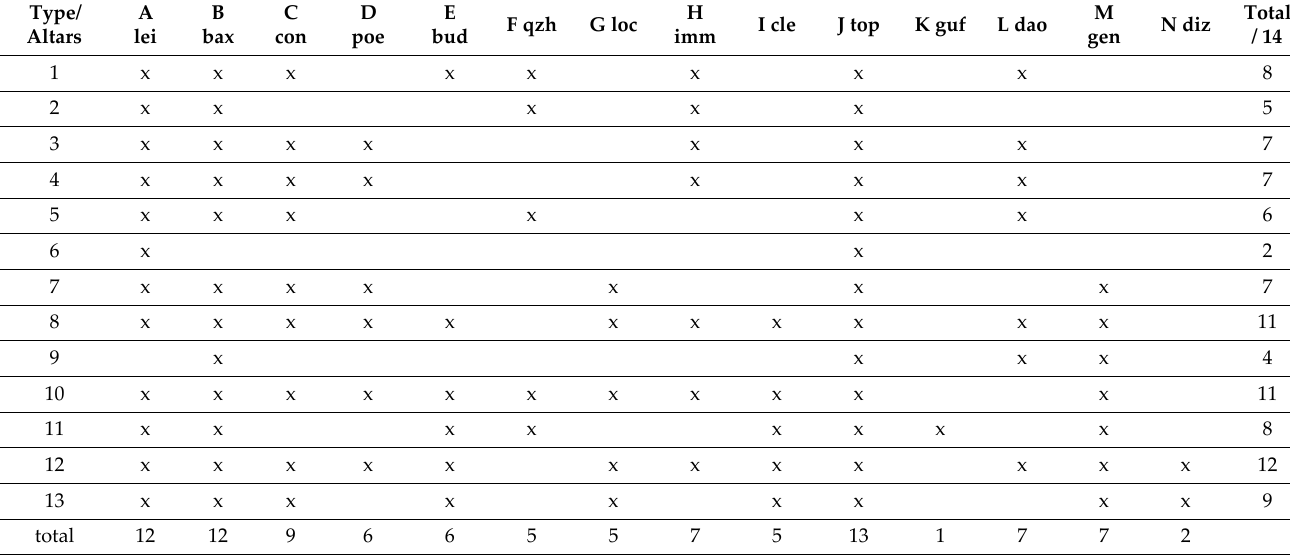
Table 1. Categories and altars.